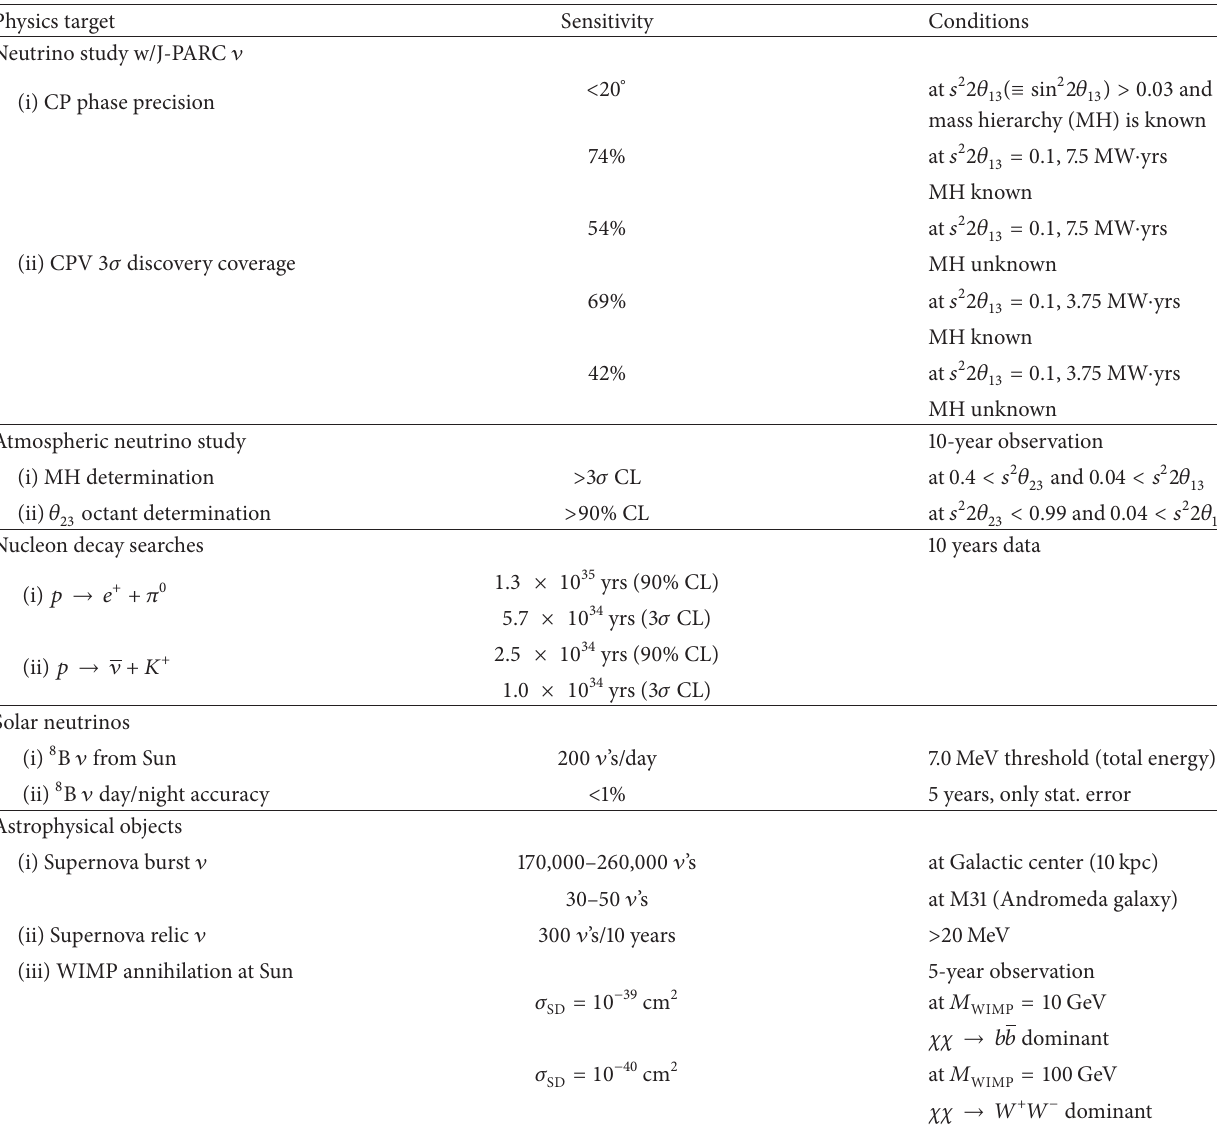
Table 8: Physics targets and expected sensitivities of the hyper-Kamiokande experiment updated from [2]. 𝜎 dependent